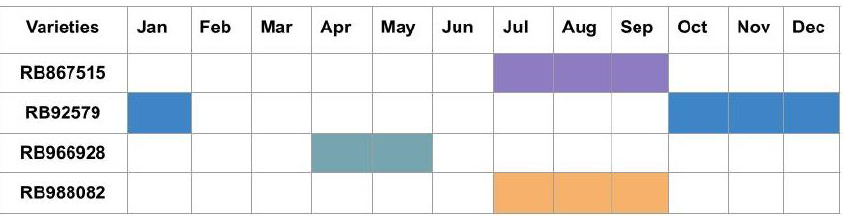
Figure 1. Sugarcane harvest cycle of varieties RB867515, RB92579, RB966928, and